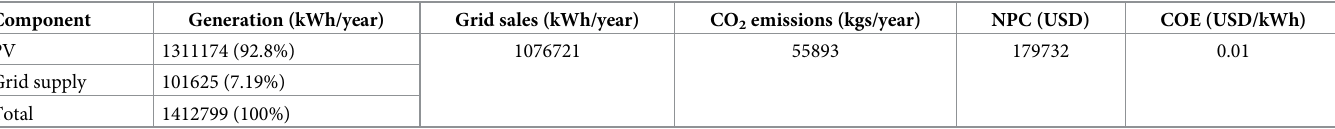
Table 6. Simulation results for